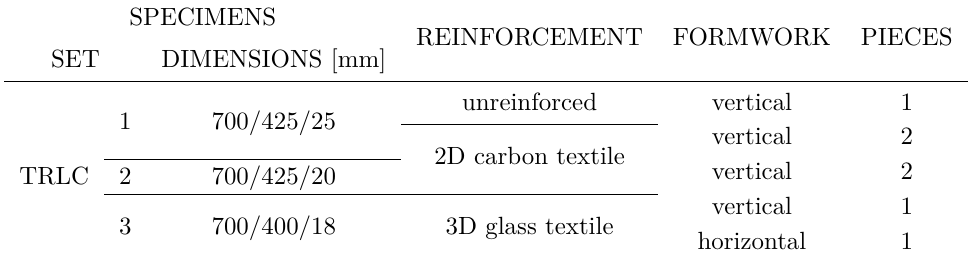
Table 1. Overview table of slab